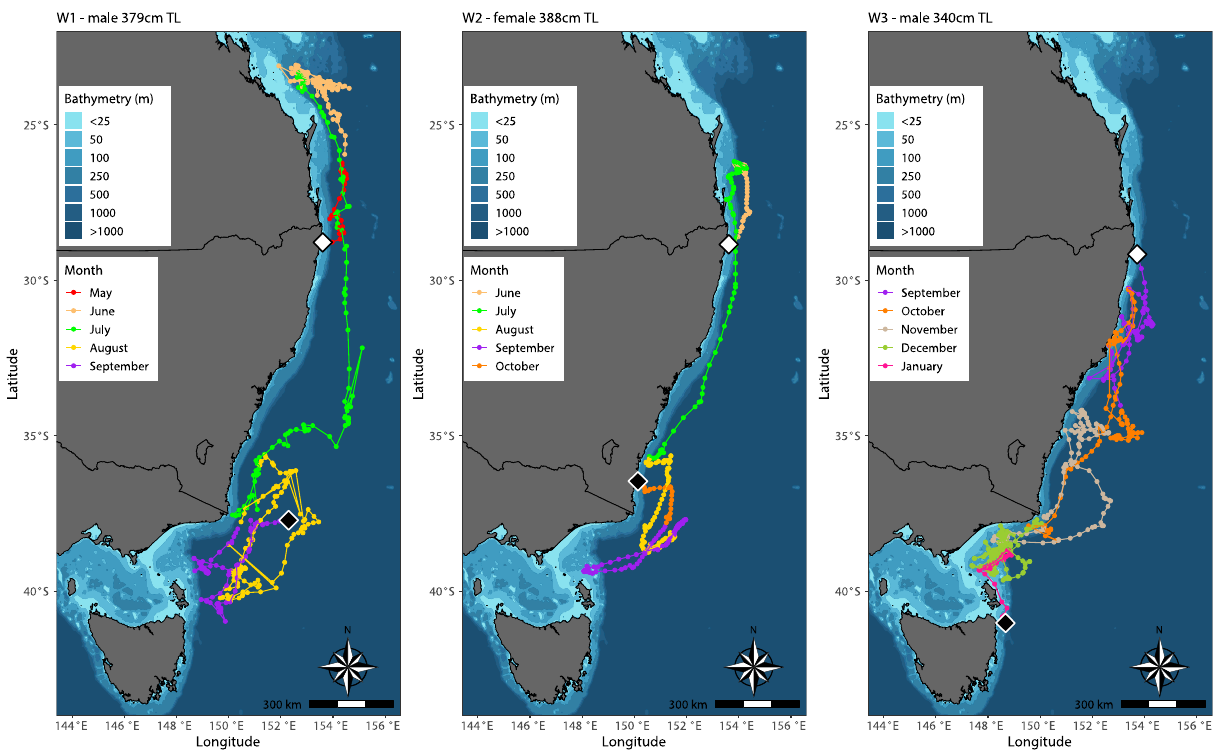
Figure 3. Track reconstruction of three white sharks ( C. carcharias ) tagged off the northern New South Wales coast of eastern Australia. Estimated track positions are colour-coded by month. Tagging locations indicated by white diamonds, and MiniPAT tag pop-up locations indicated by black diamonds. Maps were generated in R Statistical Software, version 4.1.0 [29], using R packages ‘marmap’ and ‘ggplot2′ [32,33].